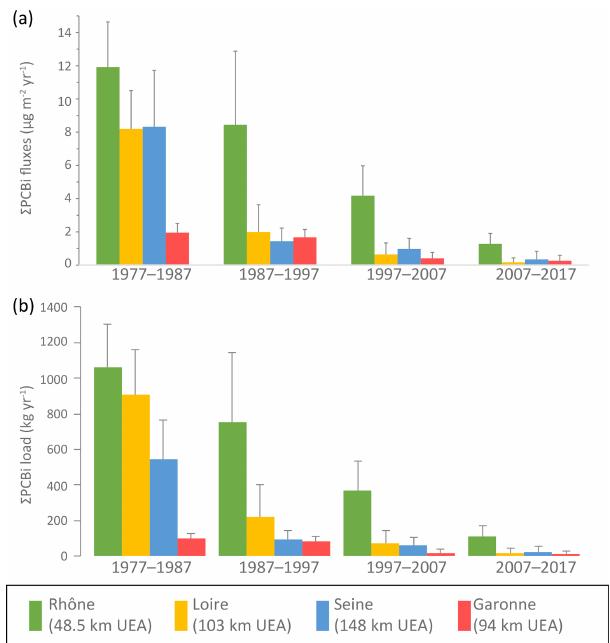
Figure 5. Comparison of specific (cid:54) PCBi flux (µgm − 2 yr − 1 ) (a) and the mean annual load (kgyr − 1 ) (b) on the French rivers. Fluxes and loads are estimated at the lower station upstream of the tidal influence: Arles–Beaucaire for the Rhône, Montjean for the Loire, Poses–Poissy for the Seine and La Réole–Lamagistère for the Garonne (see locations in Fig. 1). The distance of each station to the sea is expressed as kilometres upstream of estuarine areas